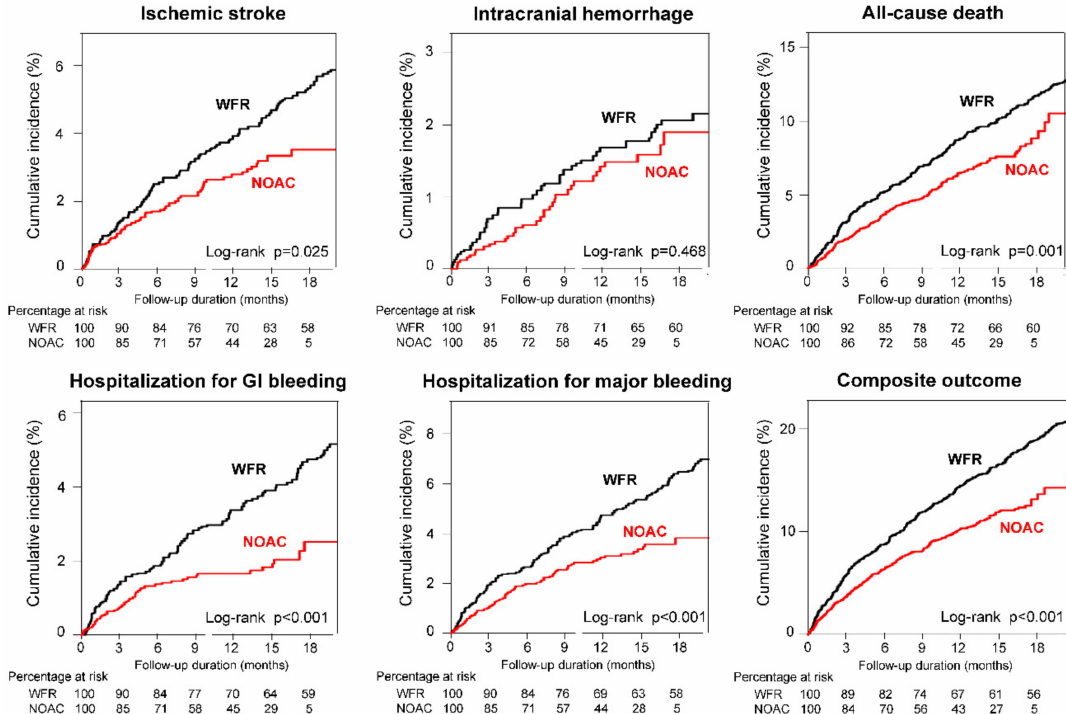
Figure 2. Weighted cumulative incidence curves of 6 clinical outcomes of NOAC versus warfarin. Compared to warfarin, NOACs showed significantly lower incidence rates of ischemic stroke, GI bleeding, major bleeding, and all-cause mortality. NOAC and warfarin groups showed similar incidence rates of intracranial hemorrhage (ICH). Overall, NOACs were associated with a lower rate of the composite outcome. Abbreviations: GI, gastrointestinal; NOAC, non-vitamin K antagonist oral anticoagulant; WFR, warfarin.